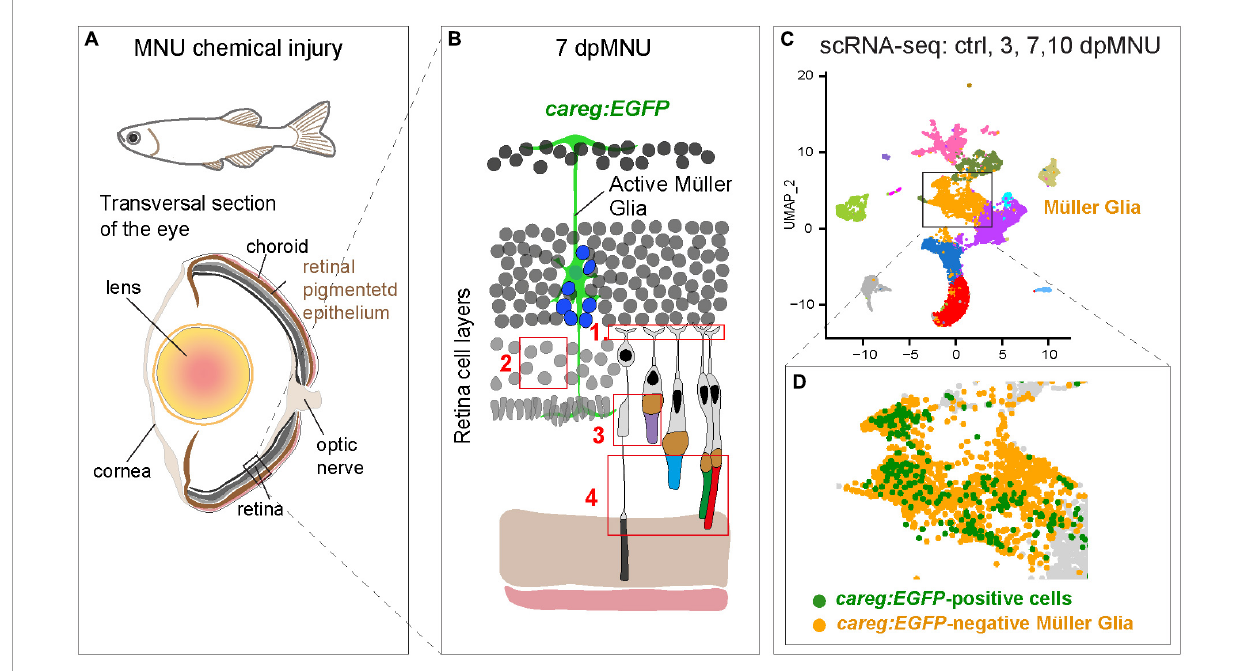
FIGURE11 Identification of molecular differences between careg:EGFP -positive versus careg:EGFP -negative Müller glia during retina regeneration. (A) Schematic illustration of the experimental model in this study. (B) Cartoon of the retina at 7 dpMNU displays the induction of careg:EGFP expression in activated Müller glia (green cell), which give rise to the formation of proliferative progenitor cells (blue nuclei). The phenotypic defects of MNU-injury are highlighted in red frames: (1) Abolishment of actin filaments in synaptic photoreceptor processes in the outer plexiform layer. (2) Decrease of rod cell bodies in the outer nuclear layer. (3) Damage of inner segments of rod photoreceptors and the outer segments of UV-cones. (4) Distortion of photoreceptor outer segments. (C) UMAP visualization of cell clusters from the RNA-sequencing data of careg:EGFP retinas. (D) careg:EGFP -positive cells are detected mostly in the cluster of Müller